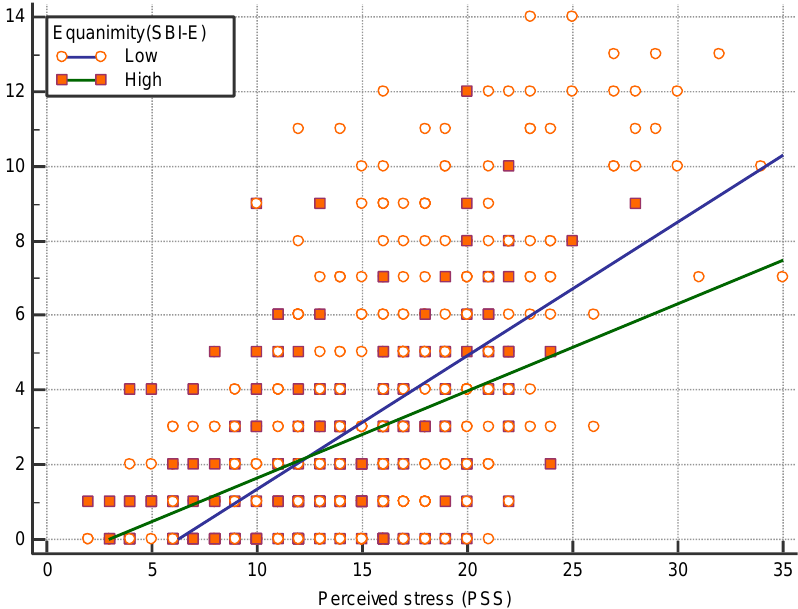
Figure 2. Regression lines between CSI-D and PSS scores based on level of equanimity.